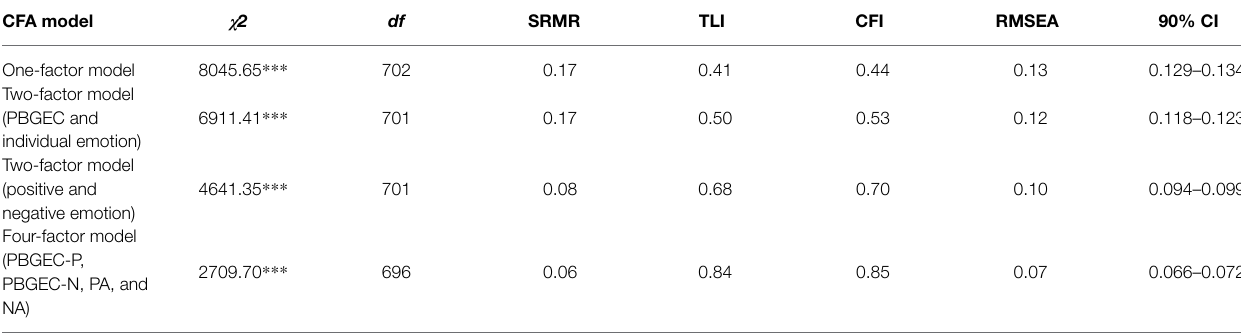
TABLE 5 | Model fit indices for PBGEC and the individual affect model.